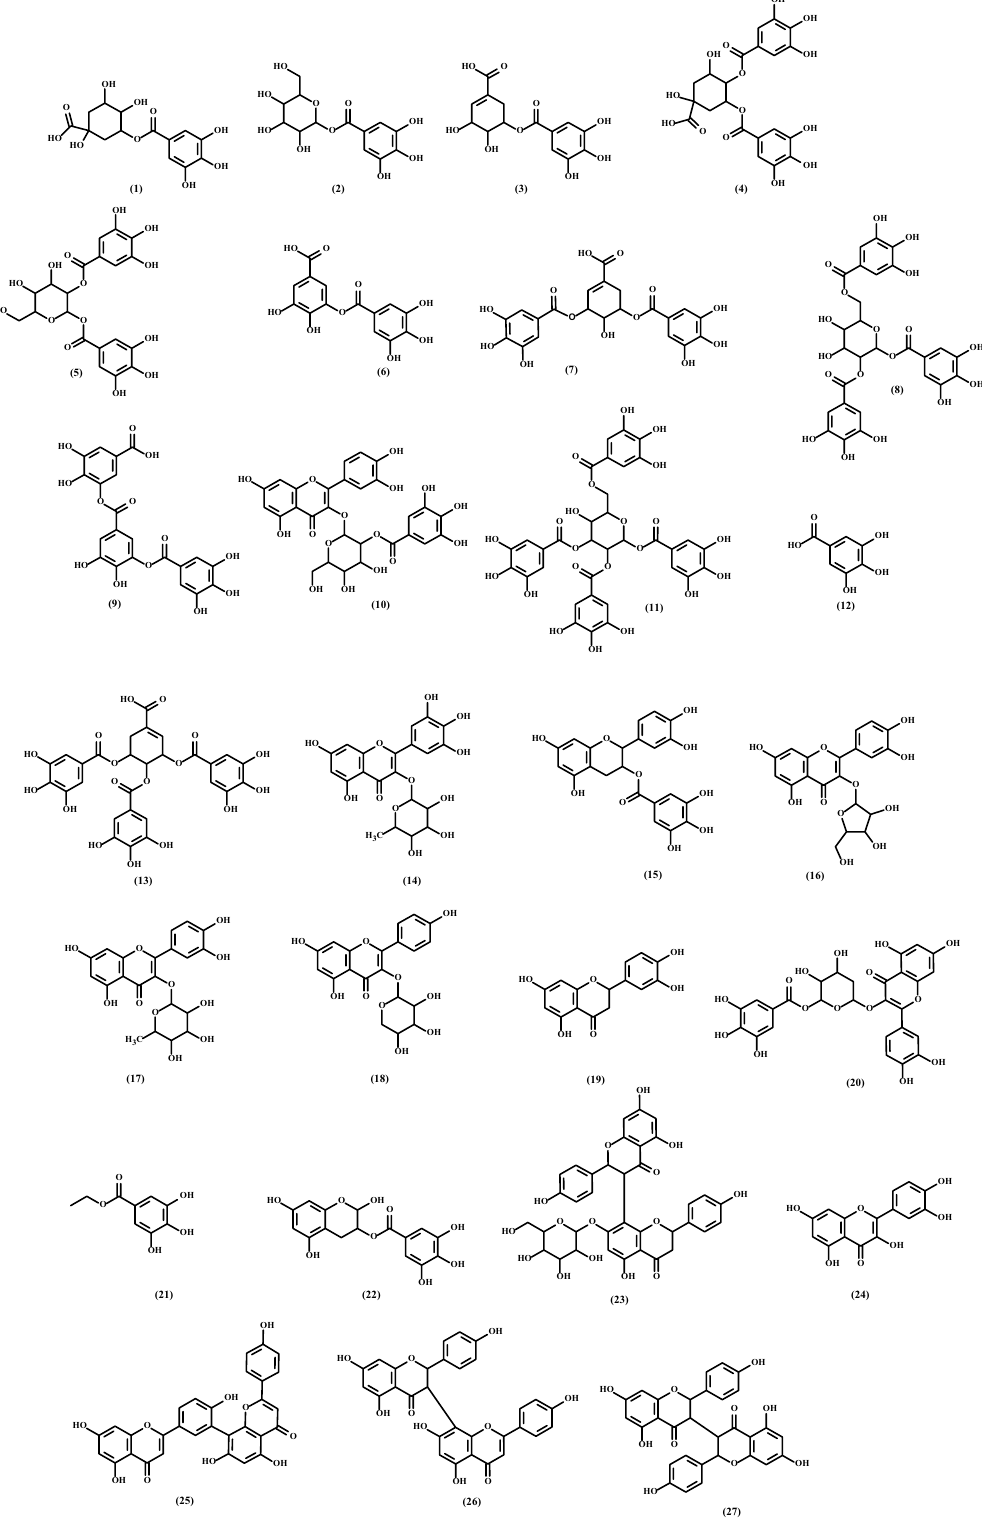
Figure 4. Chemical structures of the proposed compounds 1–27 present in the ethanolic extract of Schinus terebinthifolius (Brazilian